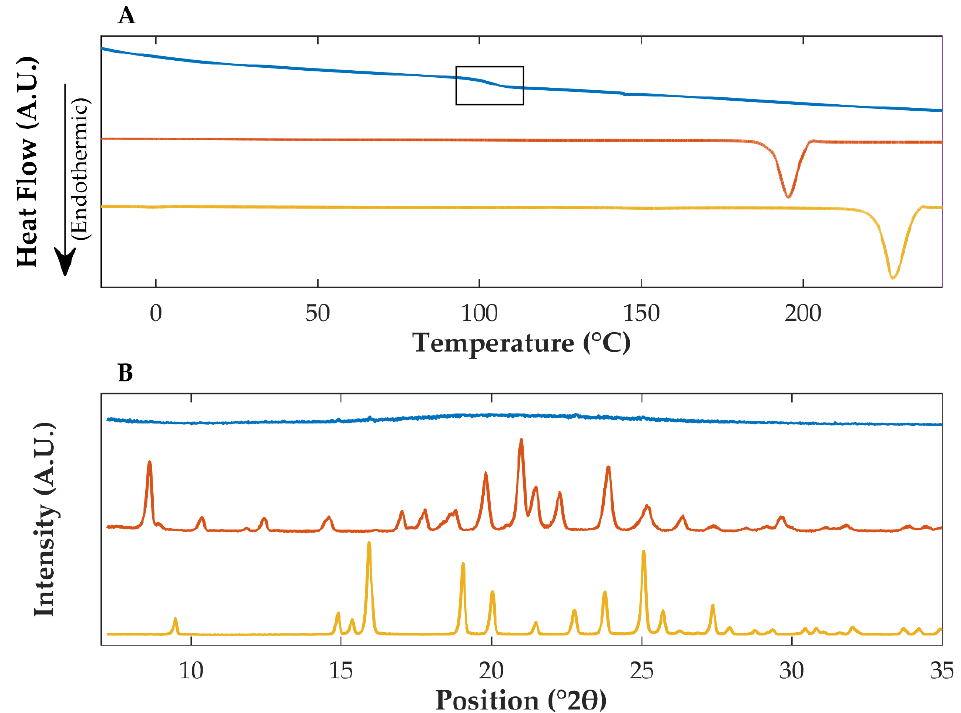
Figure 2. Differential scanning calorimetry thermograms ( A ) and X-ray powder diffractograms ( B ) of powdered crystalline saccharin (yellow), crystalline olanzapine (orange), and co-amorphous olanzapine:saccharin (blue). The glass transition of co-amorphous olanzapine:saccharin is highlighted in ( A